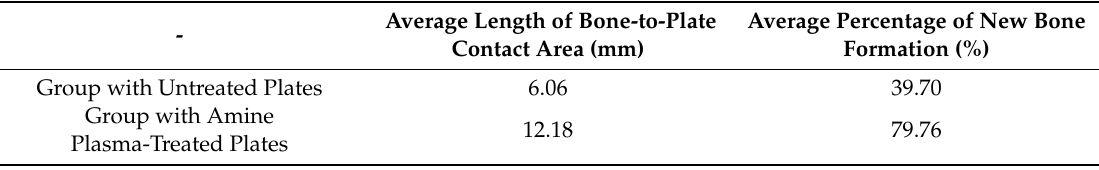
Table 2. Average lengths of bone-to-plate contact areas (the distance between the two screws is 15 mm). -